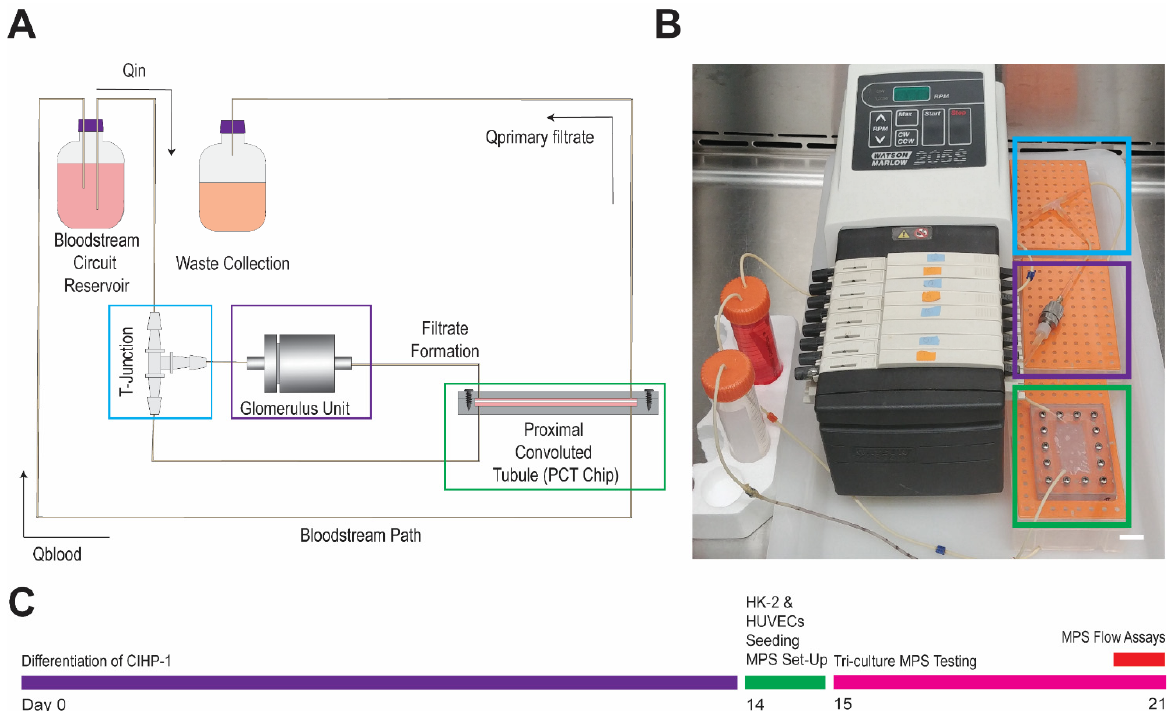
Figure 2. Construction of glomerulus and proximal convoluted tubule (PCT) MPS. ( A ) Schematic of MPS. ( B ) Image of MPS set-up. Bar = 15 mm. Blue = T-junction. Purple = glomerulus housing unit. Green = PCT device. ( C ) Timeline of MPS experiment.